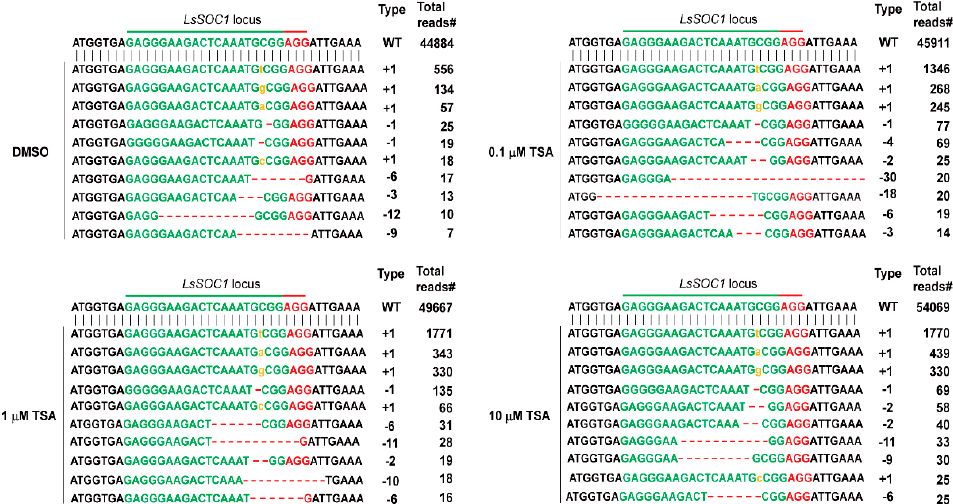
Figure 3. The representative indel types at LsSOC1 target loci generated by delivery of Cas9 and gRNAs with DMSO or various concentrations of TSA treatment. An insertion of one base pair was the most common mutation pattern among the indel patterns induced by DMSO or various concen- trations of TSA treatment at the LsSOC1 loci. The target region is shown in green letters followed by PAM (NGG; red). Yellow lower-case letters mean inserted base, and red dash means nucleotide deletion.